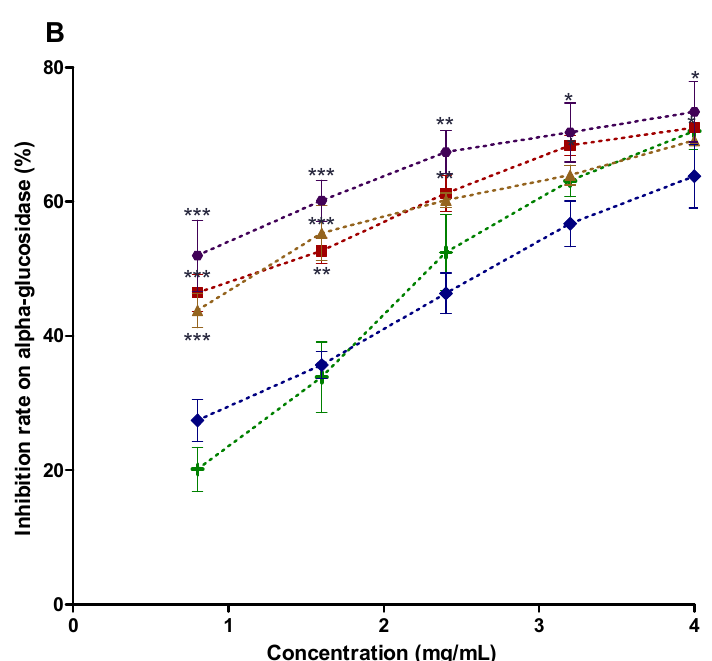
Figure 2. ( A , B ) α-amylase and α-glucosidase inhibition activities of PHF extract microencapsulated with GA, GE, MD and their combinations by freeze-drying method. Control: Acarbose; Treatment A (T A ): Freeze-dried, with 5% GA & 5% GE; Treatment B (T B ): Freeze-dried, with 5% GA & 5%